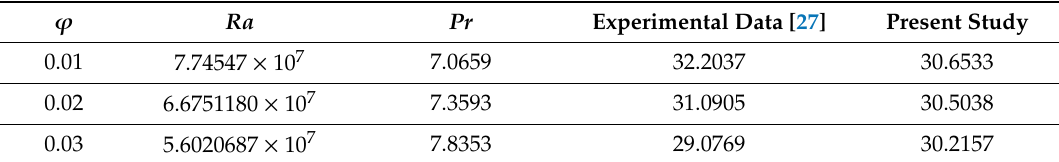
Table 1. Values of mean Nu at hot border.